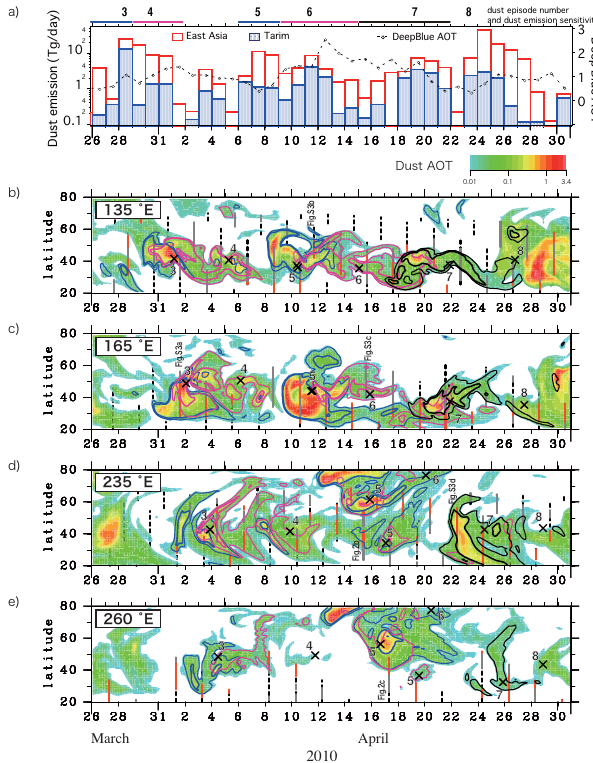
Signif- (cid:5)(cid:6)(cid:7)(cid:8)(cid:9) (cid:10)(cid:11)(cid:7)(cid:12)(cid:13) (cid:2)(cid:3)(cid:4)(cid:3) Fig. 4. (a) Daily dust emission flux (bar) over the Asia domain and MODIS Deep Blue AOT (dotted line), (b–e) Daily changes in dust AOT (color) at 135 ◦ E, 165 ◦ E, 235 ◦ E, and 260 ◦ E between 26 March and 30 April. Straight red bars indicate that dust layers were observed by CALIOP. Broken lines and gray bars indicate non-dust and cloud layers, respectively. Contours are AOT from the dust sensitivity experiment for dust episodes 3–7. dust layers observed over North America. To investigate the details of dust transport during these episodes, we selected several meridian sections to show the variation and transport of Asian dust. Figure 4a shows modeled daily dust emission flux and Deep Blue AOT for the dust source region; Fig. 4b–f show daily changes in dust AOT at 135 ◦ E, 165 ◦ E, 235 ◦ E, and 260 ◦ E from 26 March–30 April. The major dust emission events are numbered in these figures. A HYSPLIT trajectory analysis (Draxler and Rolph, 2010) was conducted to deter- mine the crossing time at each meridian. Corresponding dust event numbers are also shown for each section. Vertical bars indicate the CALIOP measurement within ± 5 degrees of the specified meridian. Straight red bars indicate that dust lay- ers were observed by CALIOP during that day. Broken lines and gray bars denote non-dust and cloud layers, respectively. Contours represent AOT from dust sensitivity experiments for dust episodes